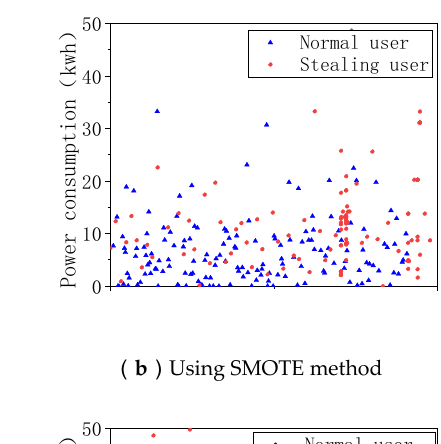
Figure 5. Comparison of CWGAN processing data set fit.